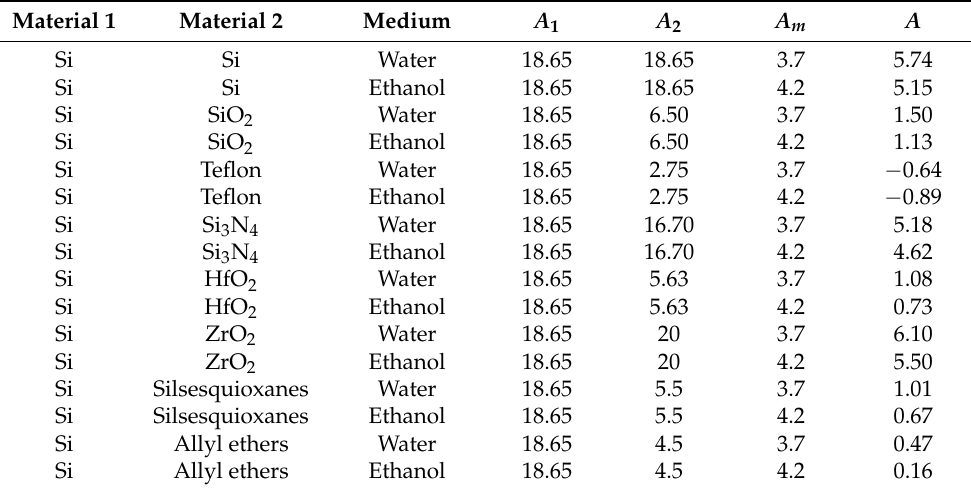
Table A1. Calculated Hamaker constants ( × 10 − 20